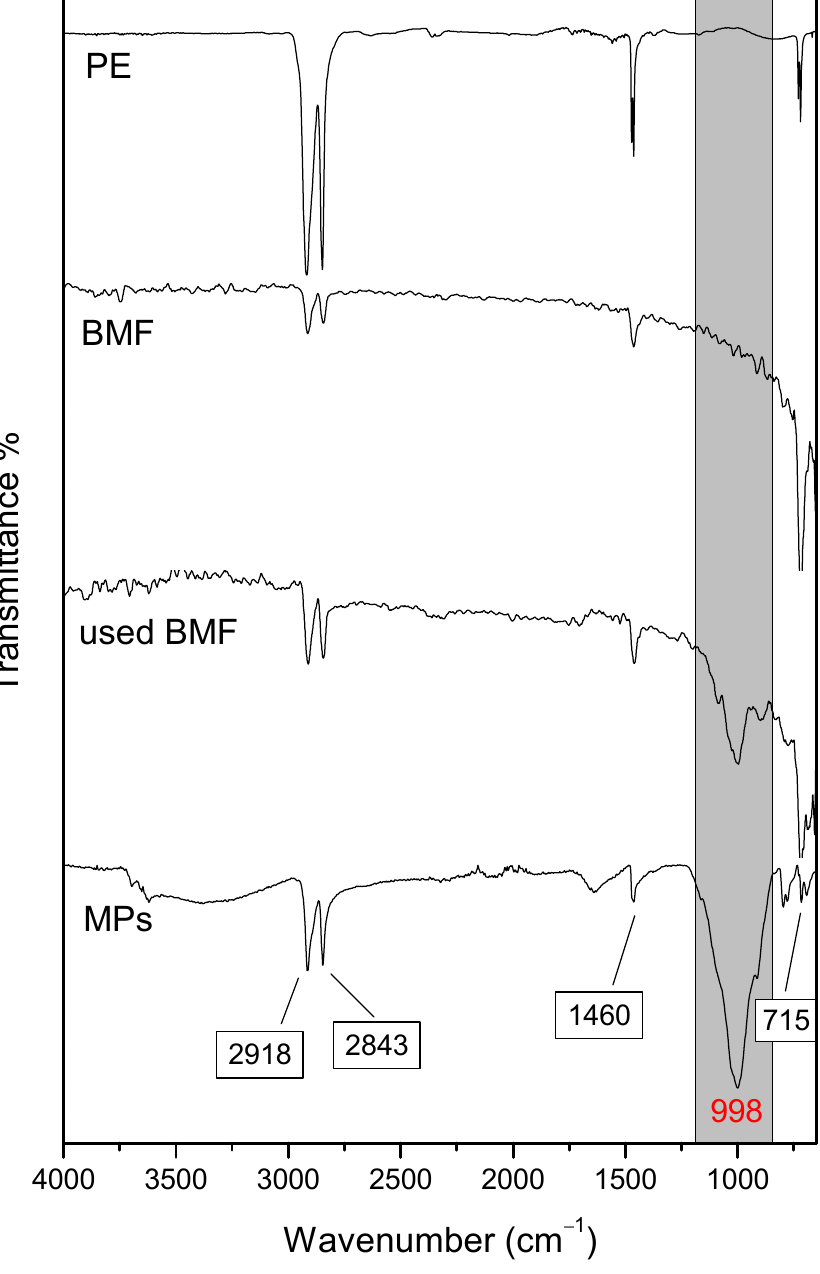
Figure 4. ATR-FTIR spectra of PE, BMF, used BMF, and the soil extracted